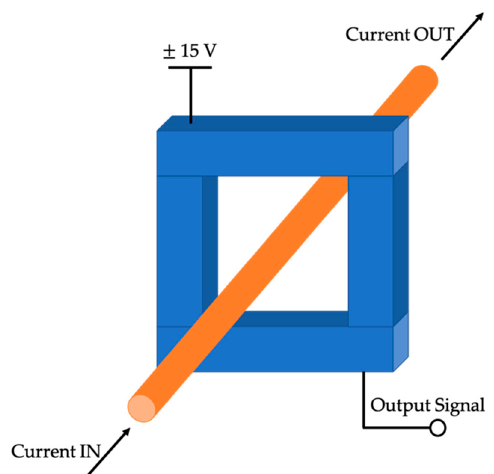
Figure 1. Measurement instrument developed for the acquisition of actual currents.